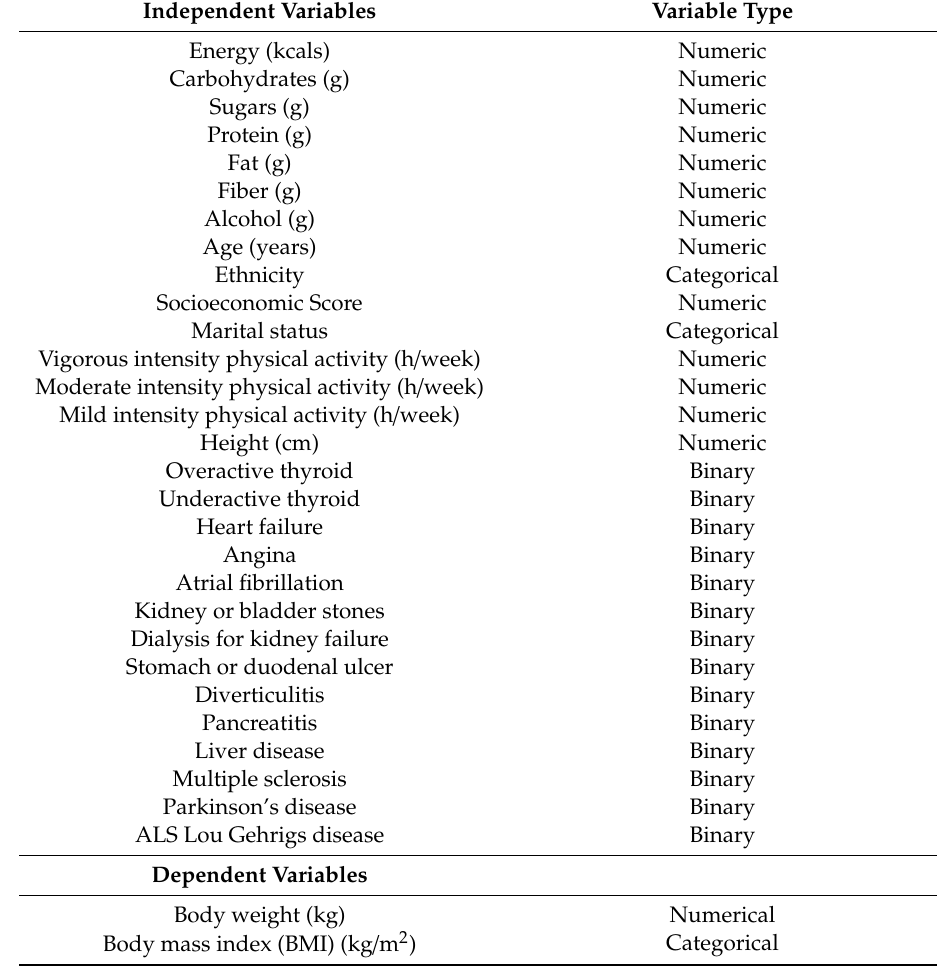
Table 1. Feature selection based final list of variables chosen for building